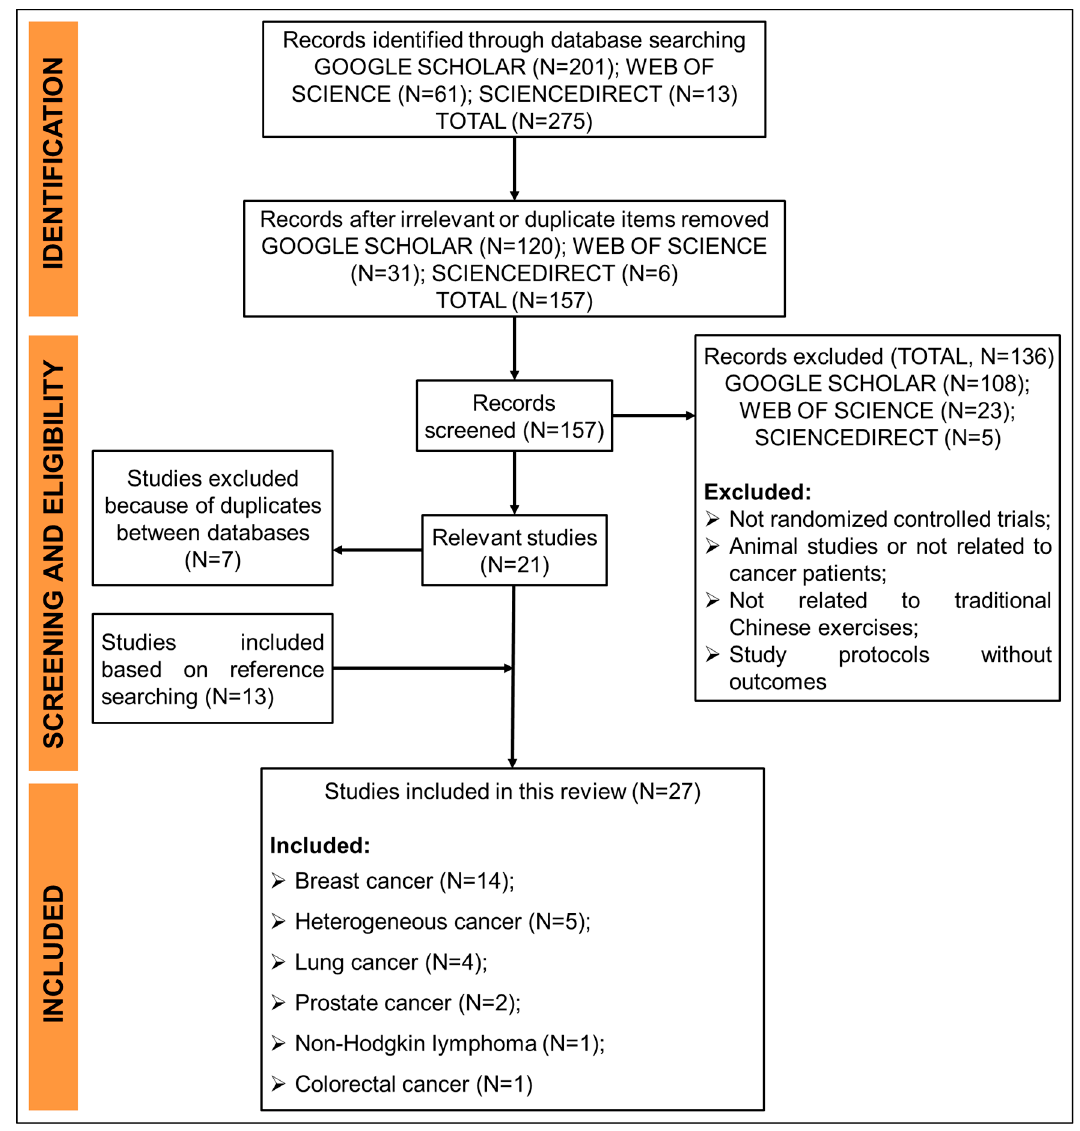
Figure 1. The search flowchart.